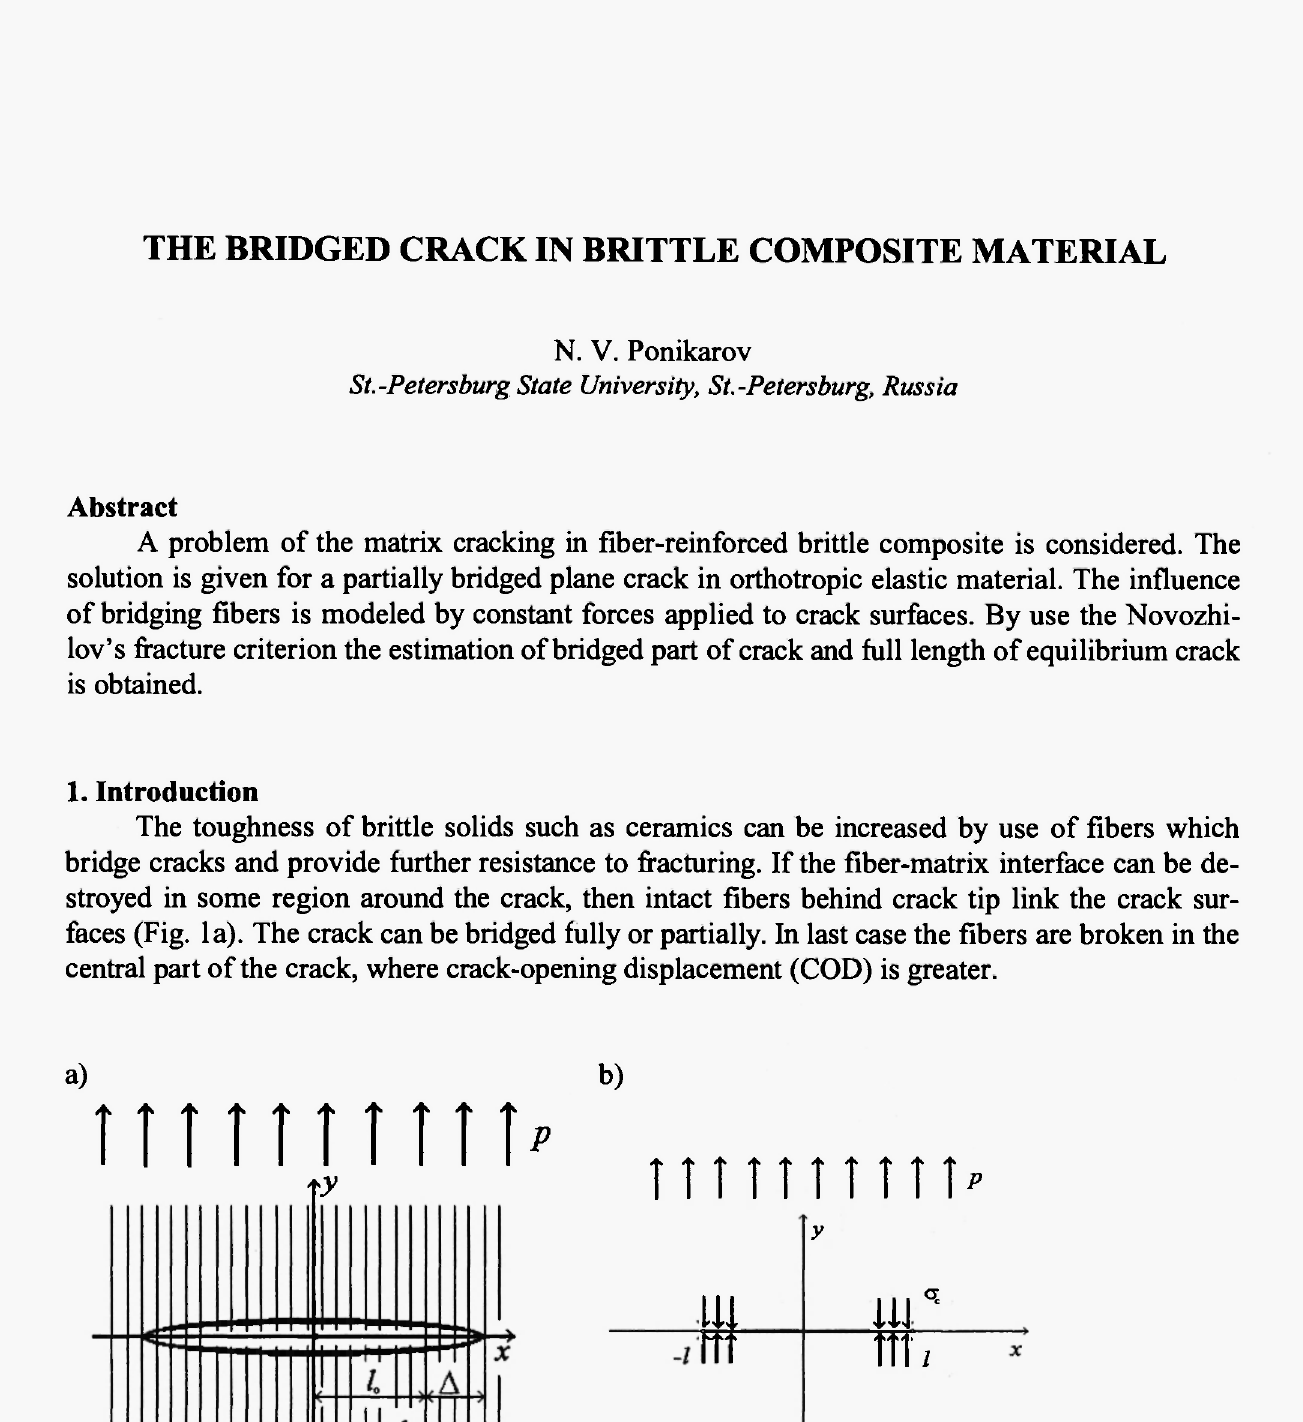
Figure 1: The bridged crack in composite material (a) and the crack in orthotropic homogeneous media